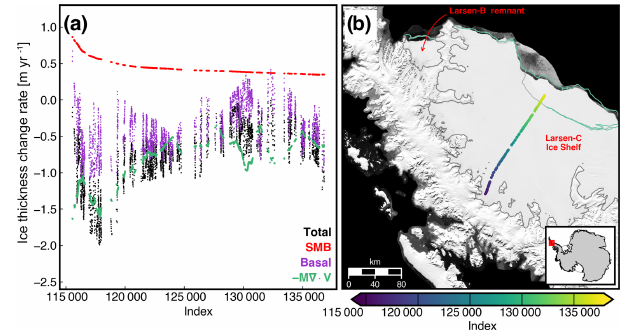
Figure 5. Measured and estimated ice thickness change rates from 2008 to 2016 for a flight line over the Larsen-C Ice Shelf (a) starting near the Whirlwind Inlet with the total measured ice thickness change rate denoted in black, SMB from RACMO2.3p2 (XPEN055) denoted in red (van Wessem et al., 2016), the flux di- vergence terms combining ice velocities from MEaSUREs (Rignot et al., 2017) and ice thicknesses denoted in green, and the residual basal thickness change rates denoted in purple. The index denotes the ATM Icessn record number for 10 October 2008. Locations of coregistered records from the flight line are shown in (b) . MEa- SUREs interferometric synthetic aperture radar (InSAR)-derived Antarctic grounded ice boundaries are denoted in gray (Moug- inot et al., 2017b). The 2016 and 2017 ice shelf extents delineated from MODIS imagery are denoted in green and light gray, respec- tively (Scambos et al., 2001). The map is overlaid on a 2008–2009 MODIS mosaic of Antarctica (Haran et al., 2014). The inset map denotes the location of the